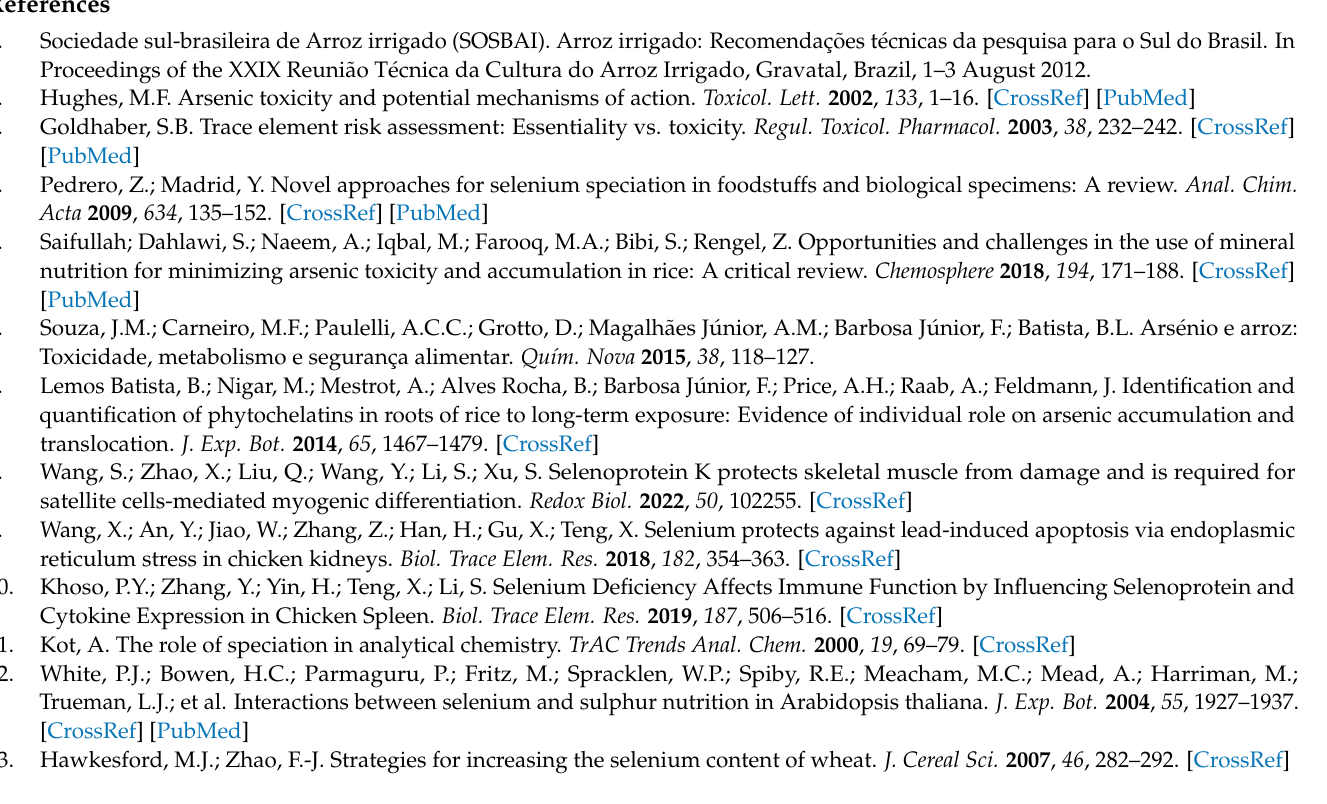
ysis; Figure S2: Representative chromatogram of typical Se speciation by HPLC-ICP-MS.